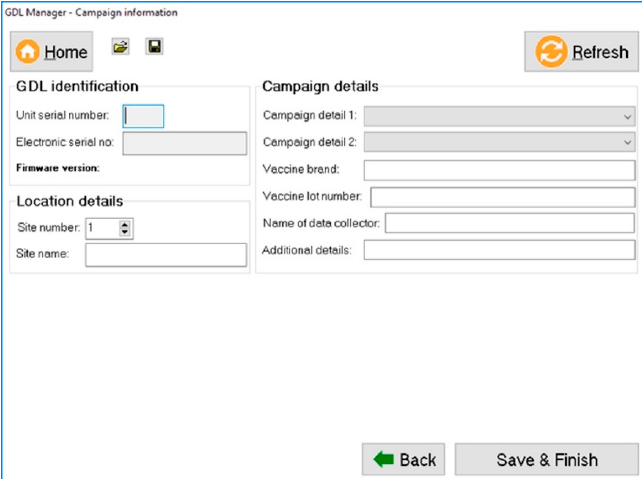
Figure 2. Screenshot of the “campaign details” screen of the GDL Manager software where data collected on the GDL can be supplemented with additional campaign information.